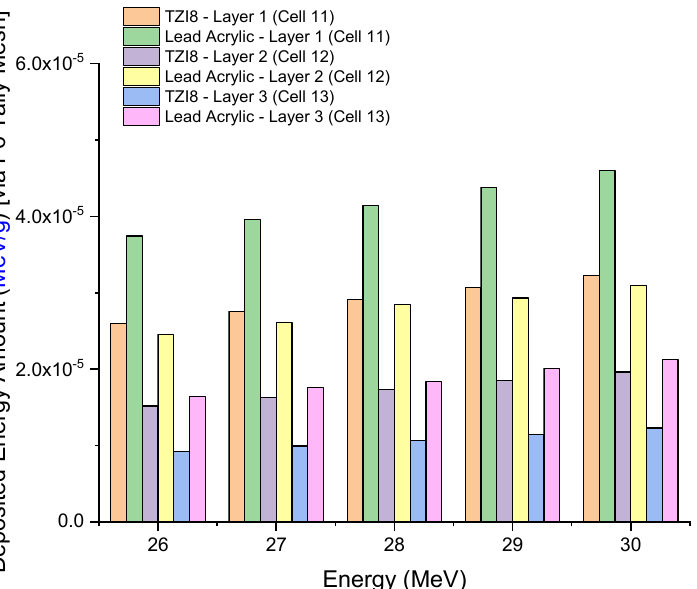
Figure 11. Variation of deposited ‐ energy amounts in three breast layers of unexposed and shielded left breast, using TZI8 and lead ‐ acrylic shielding screens.